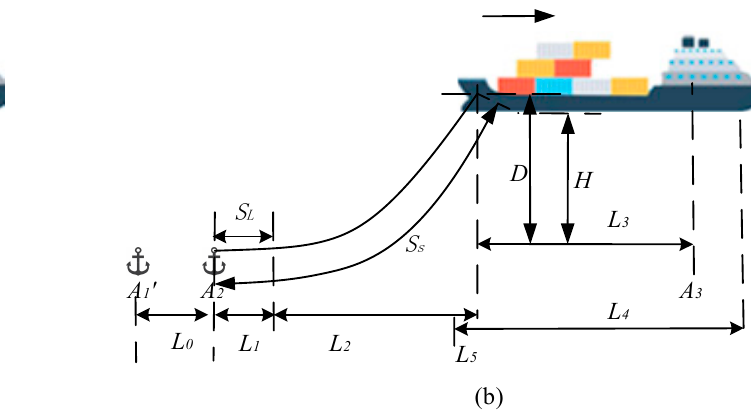
Figure 1. Process of ship backward anchoring. ( a ) The predetermined anchor position. ( b ) The ship position after anchoring operation.